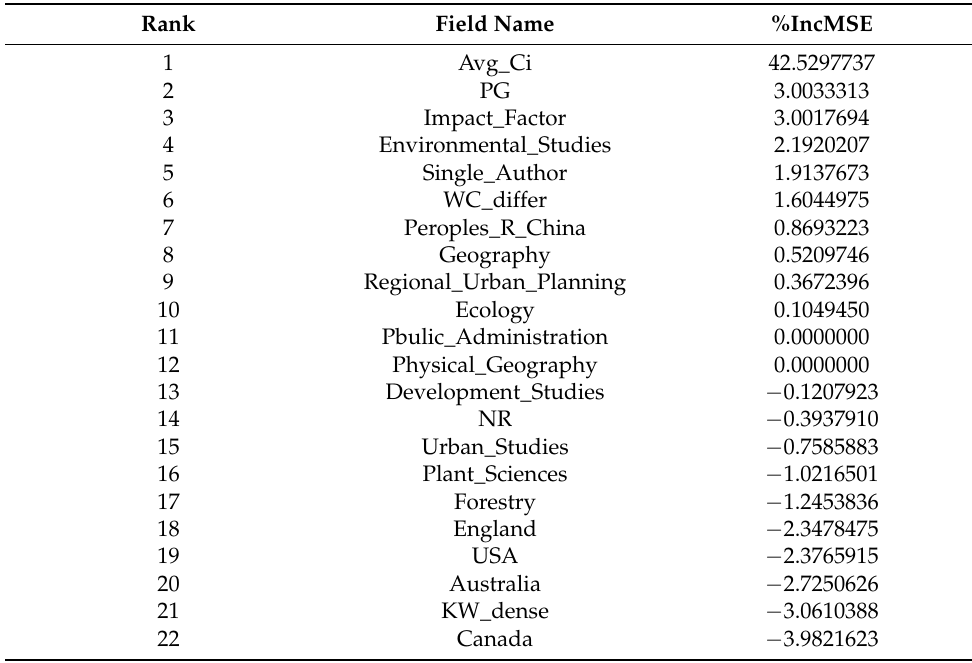
Figure 14. Burst detection of keywords. Table 9. All the features listed by IncMSE, Feature selection: all the predictors for predicting the number of citations of papers in the healthy urban planning